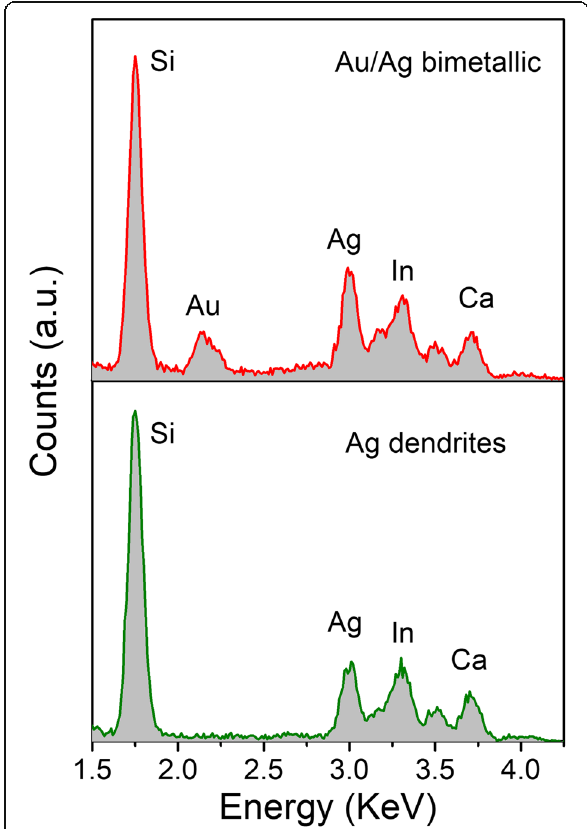
Fig. 3 Extinction spectra of the dendritic Ag nanostructures and dendritic Au/Ag bimetallic nanostructures. The spectra are stacked from bottom to top with the increase in replacement reaction